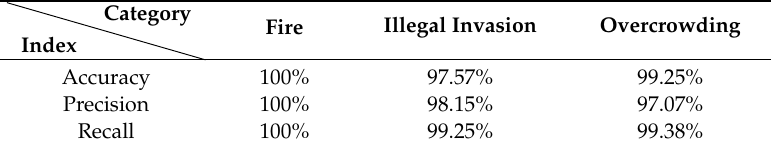
Table 5. Evaluation indices for danger classification using the SVM.